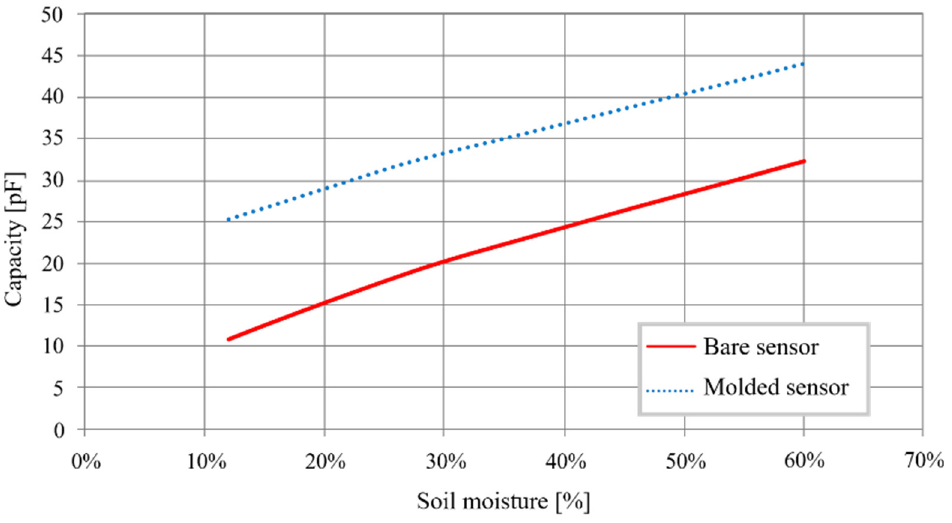
Figure 20. Molded and bare sensor capacitance as a function of humidity.